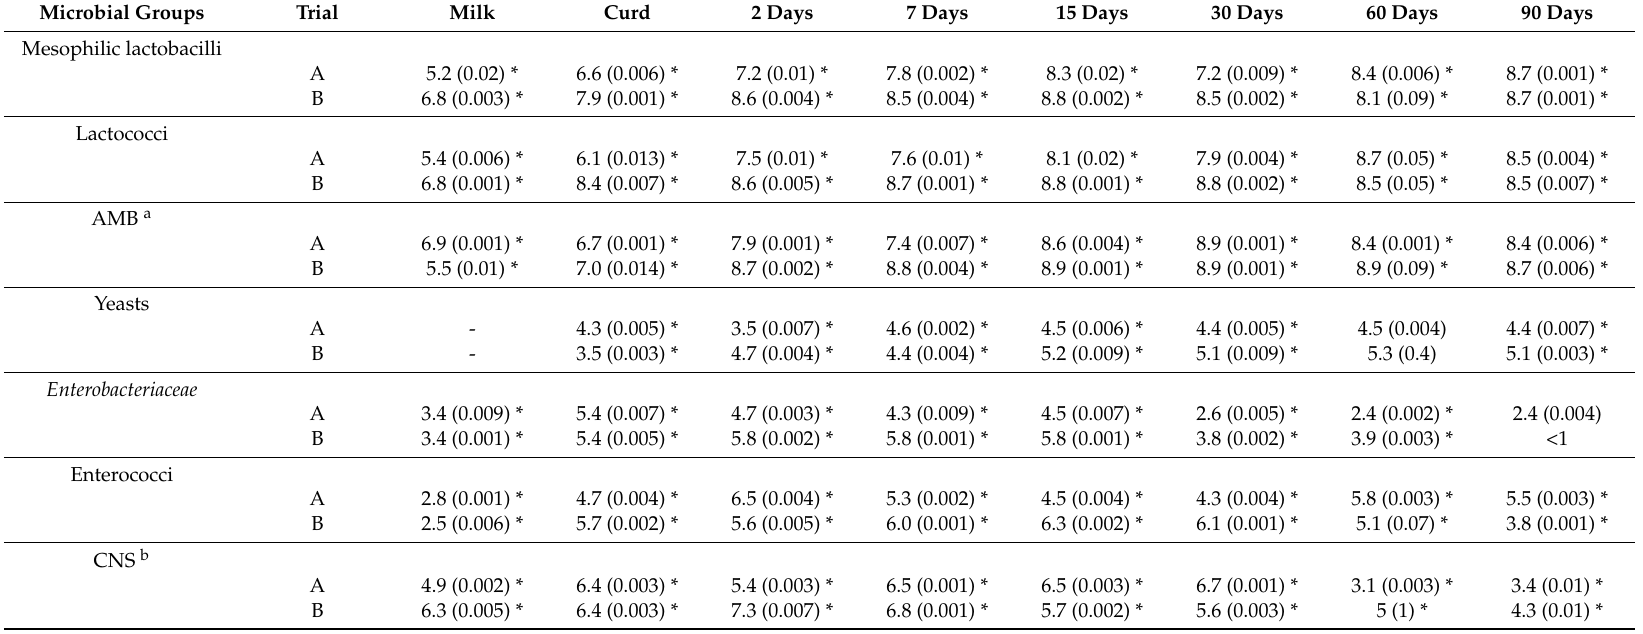
The data are reported as mean (S.D.); samples for each microbial group at the same ripening time marked with * showed statistically significant differences ( p < 0.05). a aerobic mesophilic bacteria, b coagulase-negative